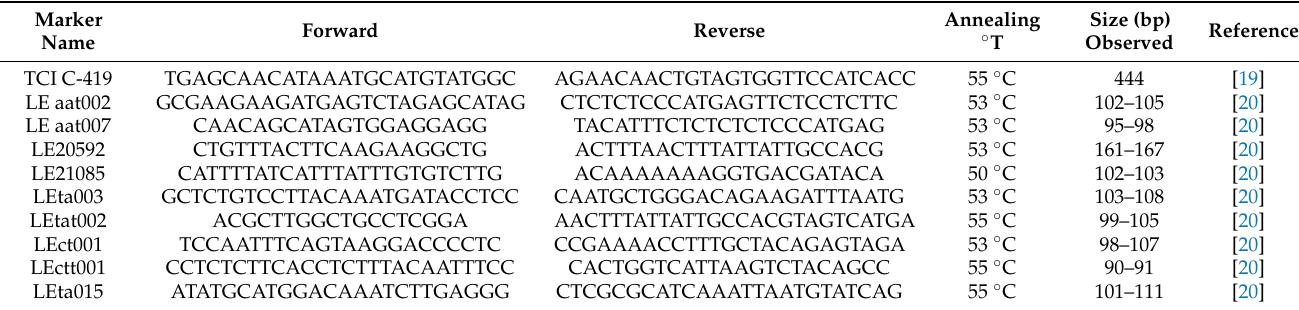
Table 1. Forward and reverse primer sequences, annealing temperature and amplified size for the microsatellite markers used to genotype the 21 tomato accessions of ‘San Marzano’ and ‘Re